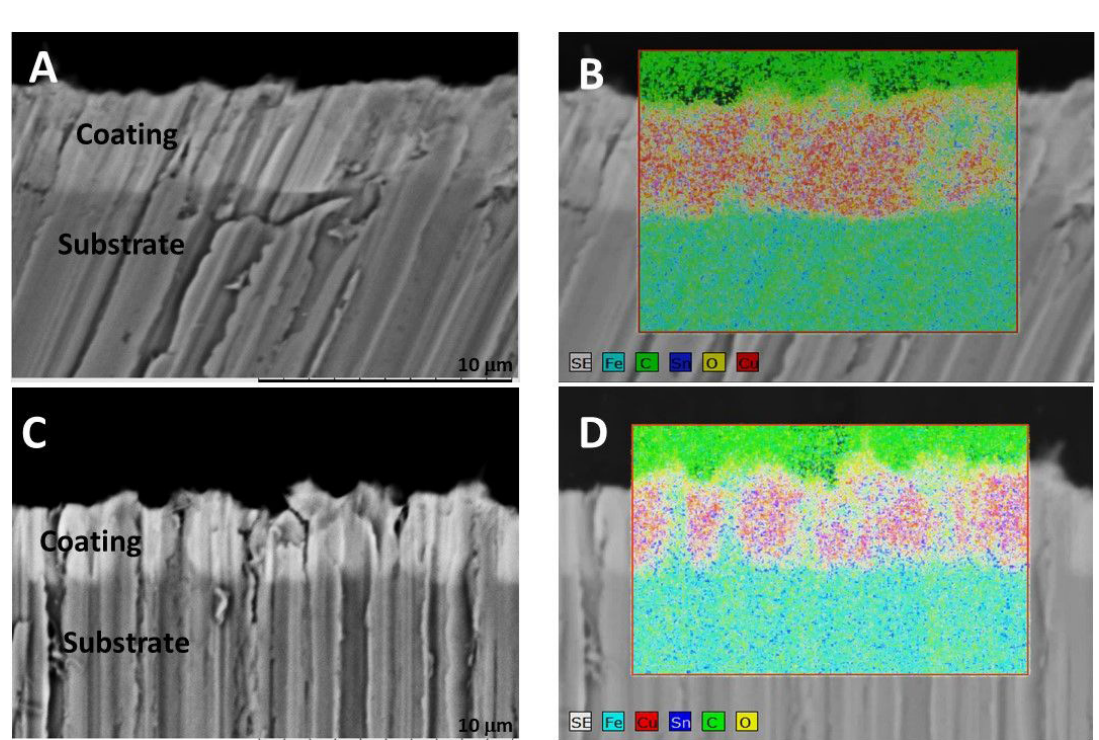
Figure 10. Cross-section images and EDS mapping analysis of the coatings produced using j = 80 A m -2 (Experiment 3, A, B) and j = 167 A m -2 (Experiment 2’, C, D) after 24 h of immersion in NaCl 0.5 mol L -1 c